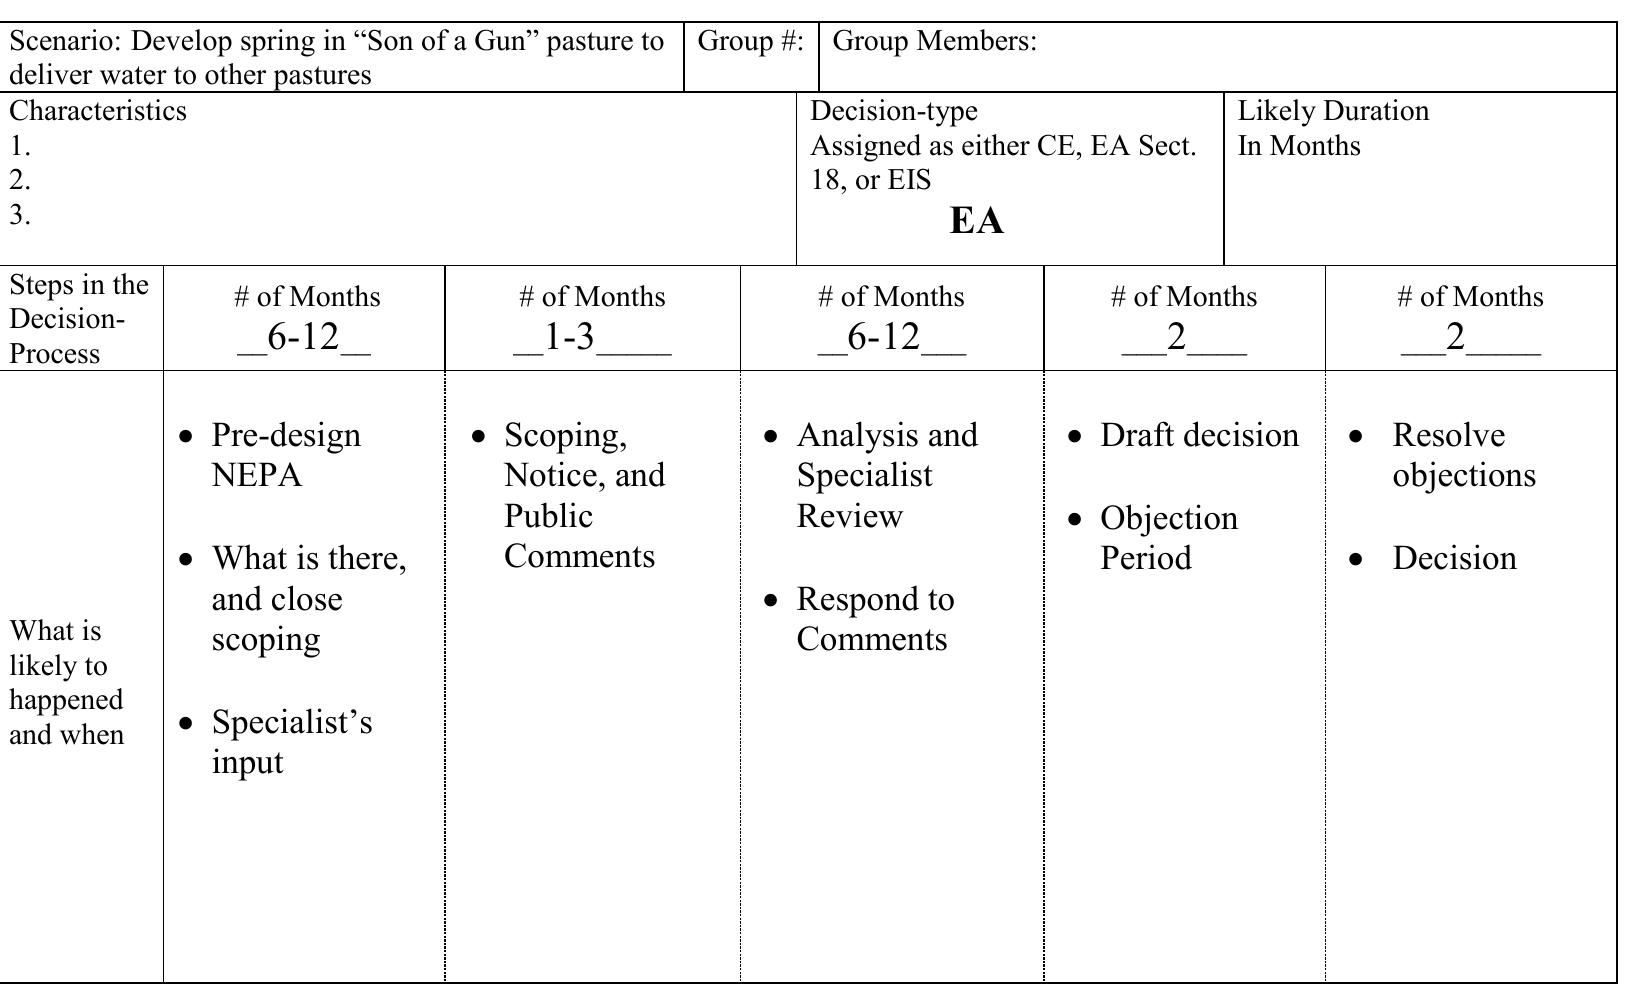
Figure A1.2: Example of completed Worksheet for an EA (Environmental Assessment): Develop spring in “Son of a Gun” to deliver water to other pastures Scenario: Develop spring in “Son of a Gun” pasture to deliver water to other